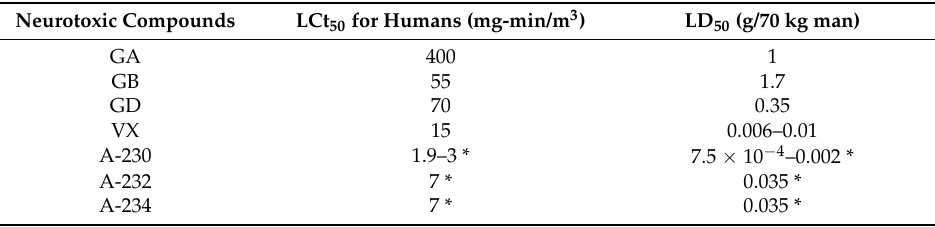
Table 2. Toxicological data of some nerve agents